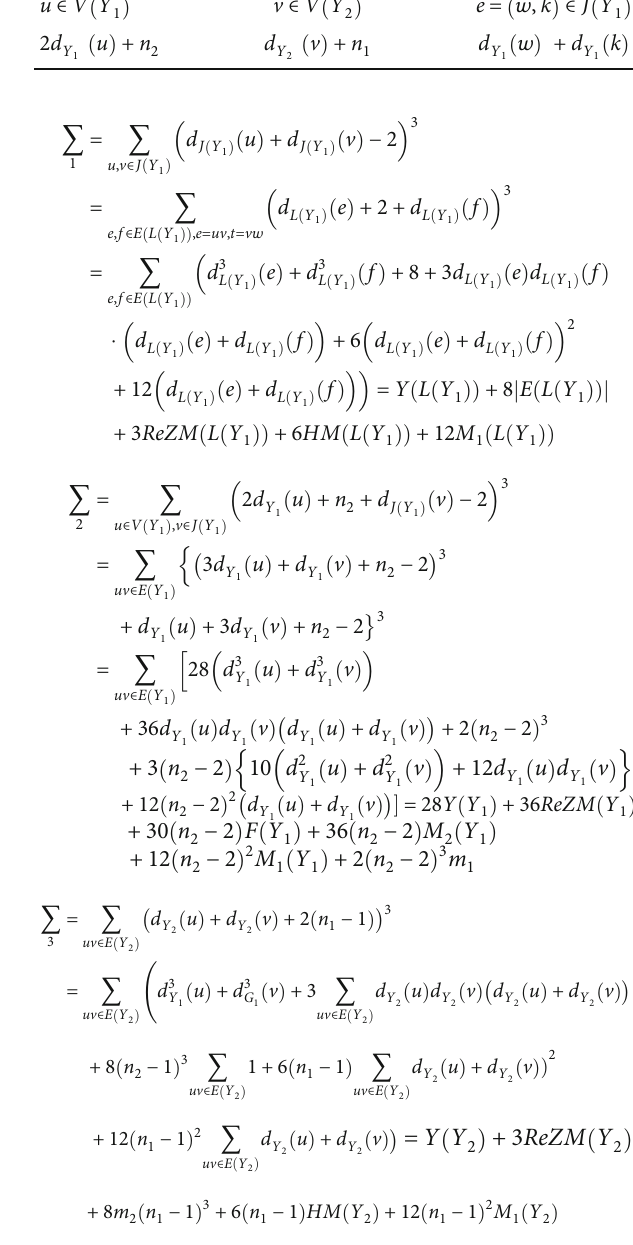
Table 7: The degree distribution of Y